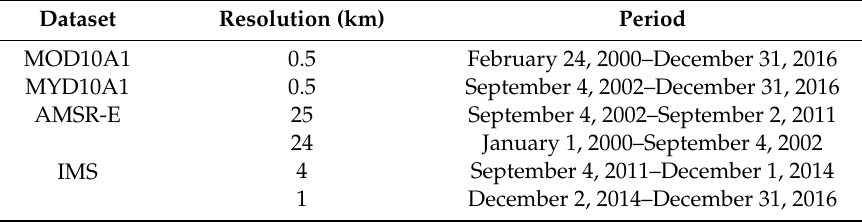
Table 1. Remote sensing data used in this